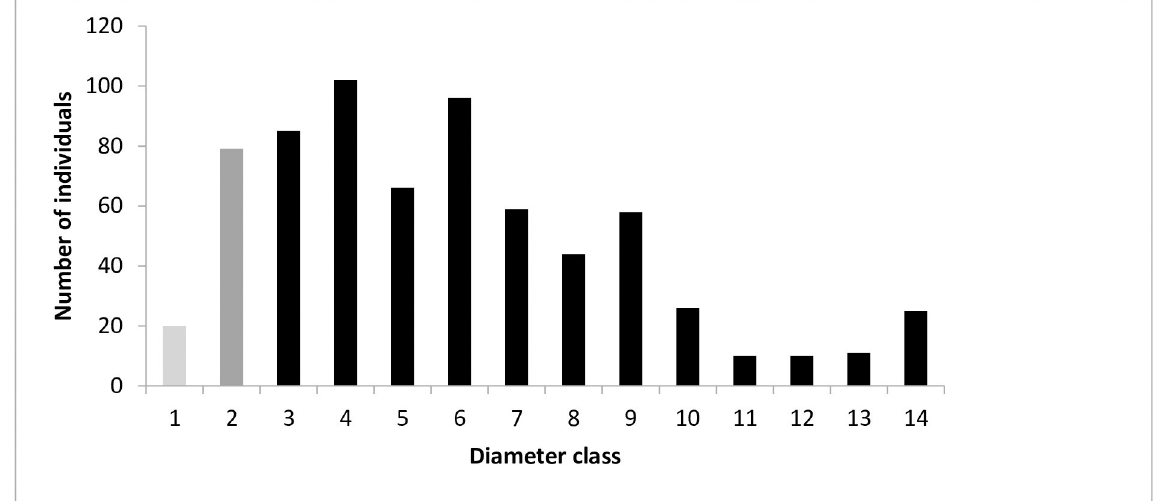
Fig 1. Diameter class distribution of O . europaea subsp. cuspidata in Hugumburda dry Afromontane forest in northern Ethiopia (1 = < 0.8; 2 = 0.8–2.0; 3 = 2.1–3.3; 4 = 3.4–4.6; 5 = 4.7–5.9; 6 = 6–7.2; 7 = 7.3–8.5; 8 = 8.6–9.8; 9 = 9.9–11.1; 10 = 11.2–12.4; 11 = 12.5–13.7; 12 = 13.8–15.0; 13 = 15.1–16.3 and 14 > 16.3 cm). Seedlings, light grey bar; saplings, dark grey bar; and adult trees, black bars.